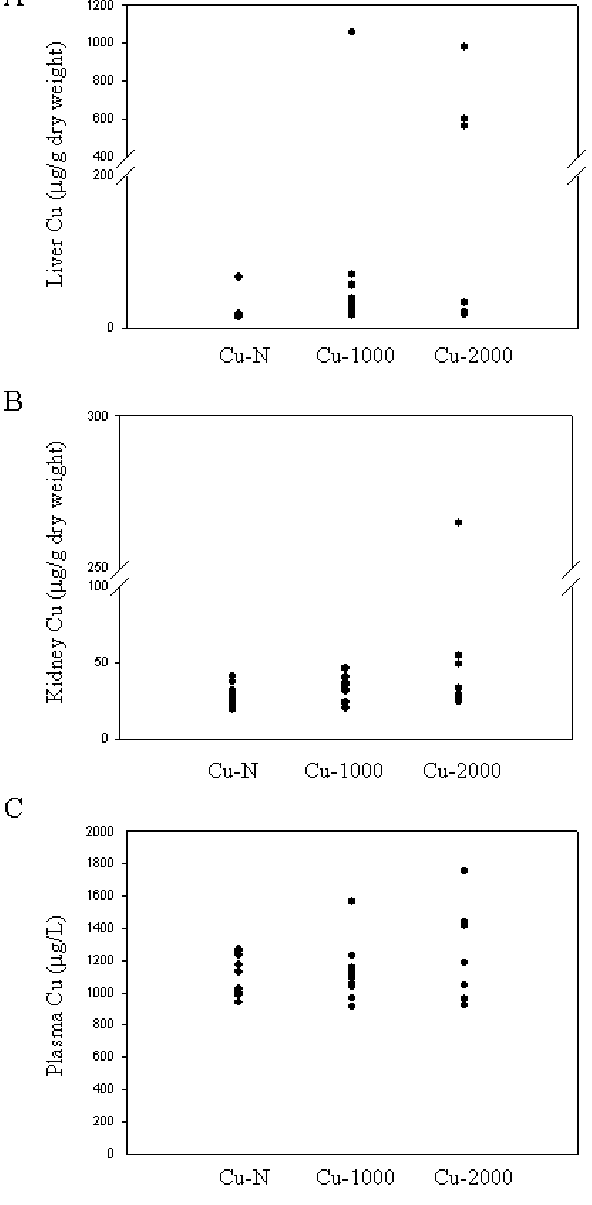
Figure 1. Cu concentrations in liver ( A ), kidney ( B ) and plasma ( C ) of rats fed diets with normal or high amounts of Cu. Each solid circle corresponds to 1 rat, n = 12, 12 and 7 for Cu-N, Cu-1000 and Cu-2000,